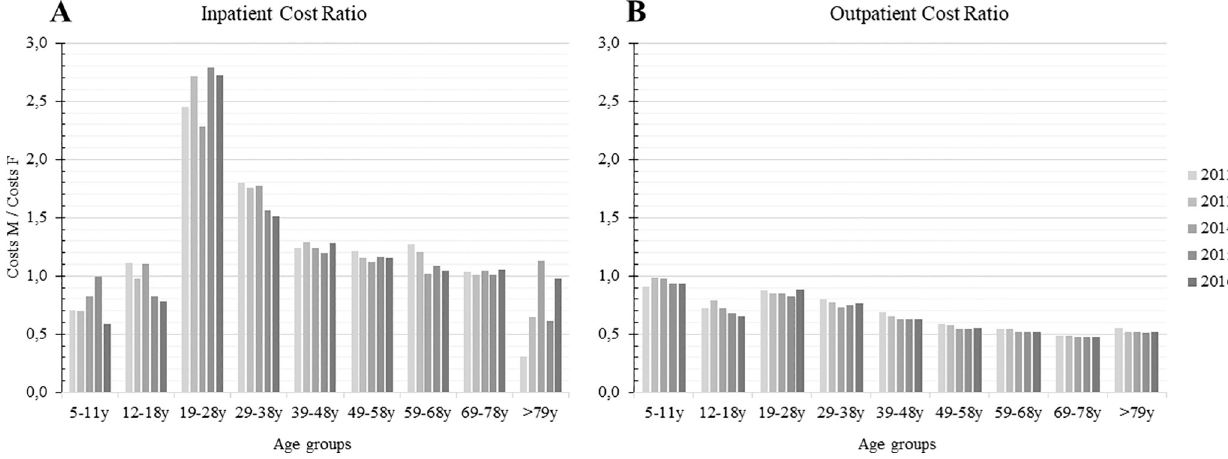
Fig 1. Ratio of the treatment expenses with low back pain (LBP) in Brazil (2012–2016), between male (M) and female (F) individuals (A: Inpatient care; B: Outpatient services).